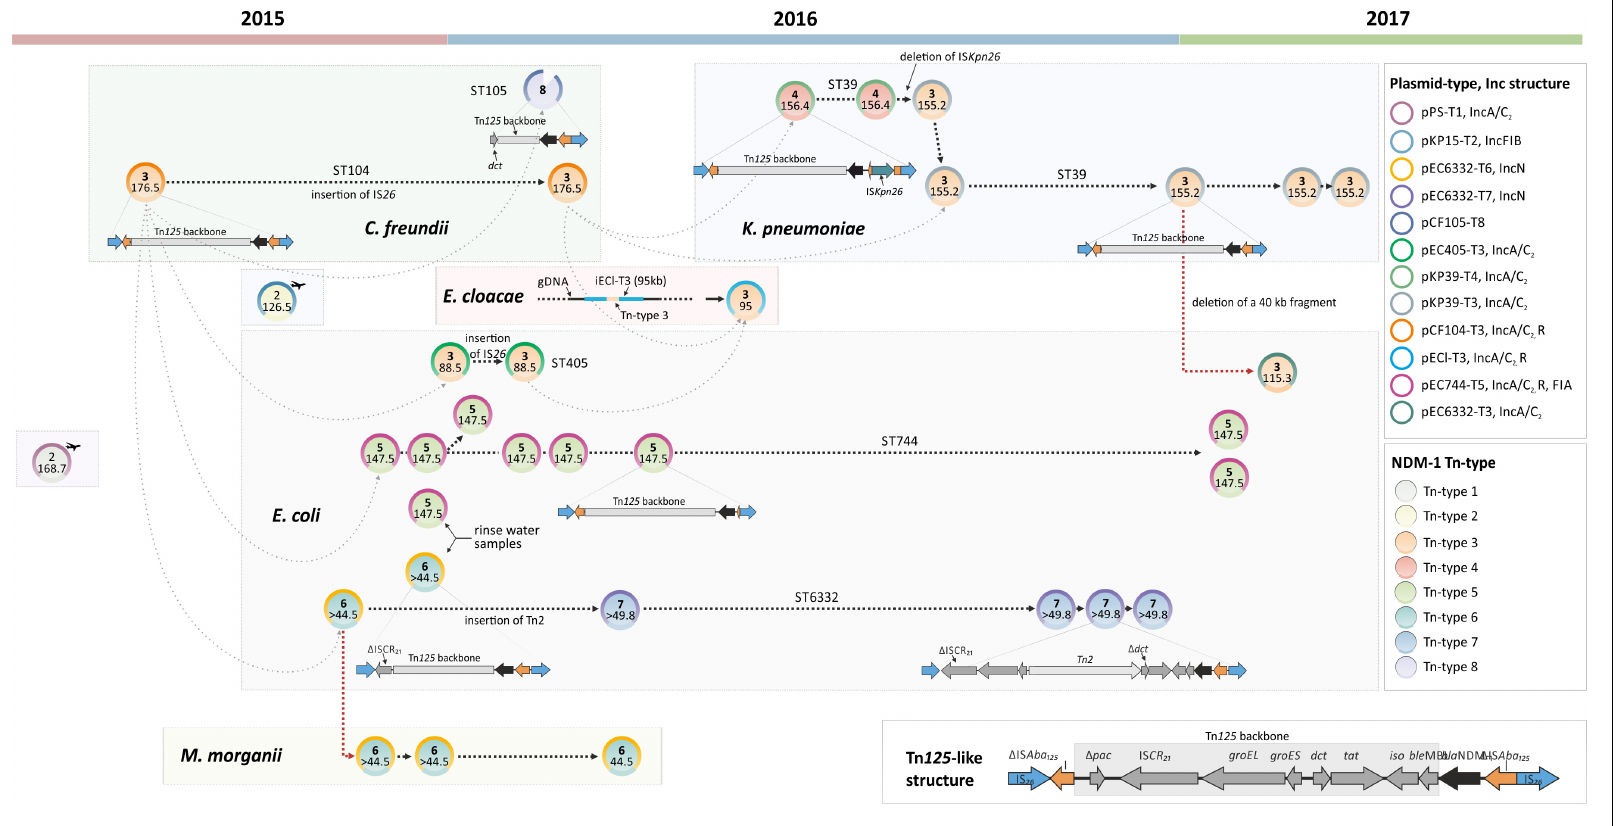
FIGURE 5 | Scheme of NDM-1-encoding plasmids and potential intra-/interspecies transmission pathways between Enterobacterales isolates in a German hospital from 2015 to 2017. The illustrated plasmids are horizontally aligned to date of isolation of the respective strain. Plasmid- and Tn-types are represented by color-coded circles and fillings, respectively (see legend on right side). Upper numbers (bold) within plasmid rings highlight Tn-types, while the numbers below show the plasmid size [kb]. The reconstructed transposon structures are schematically illustrated beneath the corresponding plasmids. Directed dotted lines indicate possible vertical (black) and horizontal (red) transmission routes, while gray-shaded lines hypothesize possible transfers of the respective bla NDM - 1 carrying transposon. At the bottom, the Tn 125- like structure is shown in detail (Tn-type 3). Two bla NDM - 1 carrying plasmids belong to isolates collected from patients with a travel history and, thus not linked to the outbreak (indicated by airplane